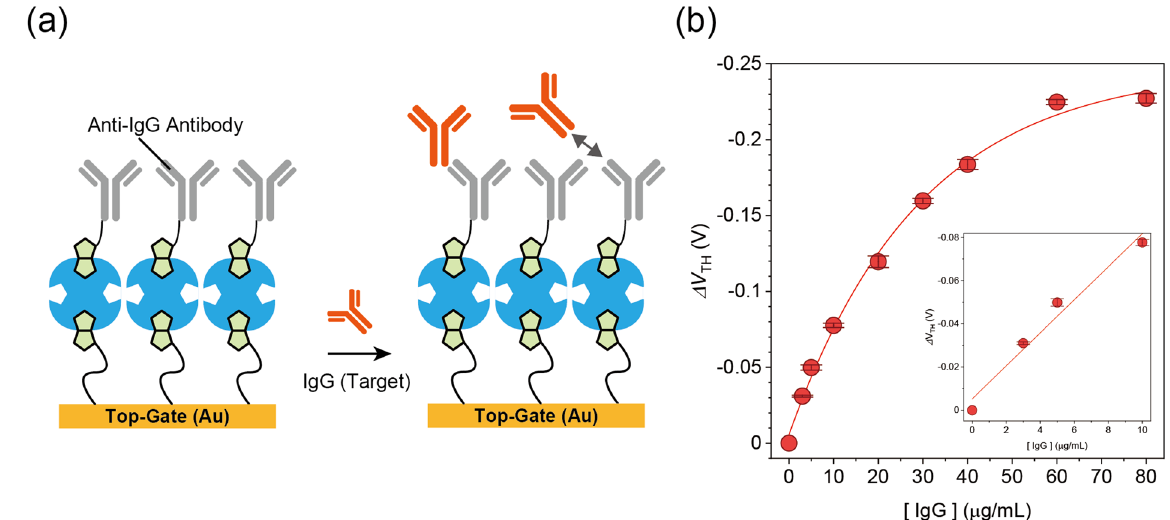
Fig. 4 Label-free immunoassay for IgG. a Schematic illustration of the sensing portion on the top-gate electrode modi fi ed with anti-IgG antibody. b Changes in the threshold voltage ( V TH ) of the OTFT induced by the IgG protein at each concentration in a PBS solution with 0.1 wt% BSA. The number of measurement cycles for each condition was fi